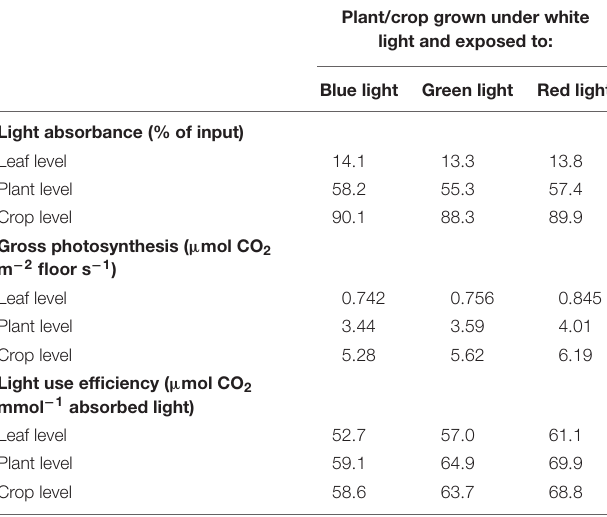
TABLE 5 | Modeled light absorbance, gross photosynthesis and light use efficiency.